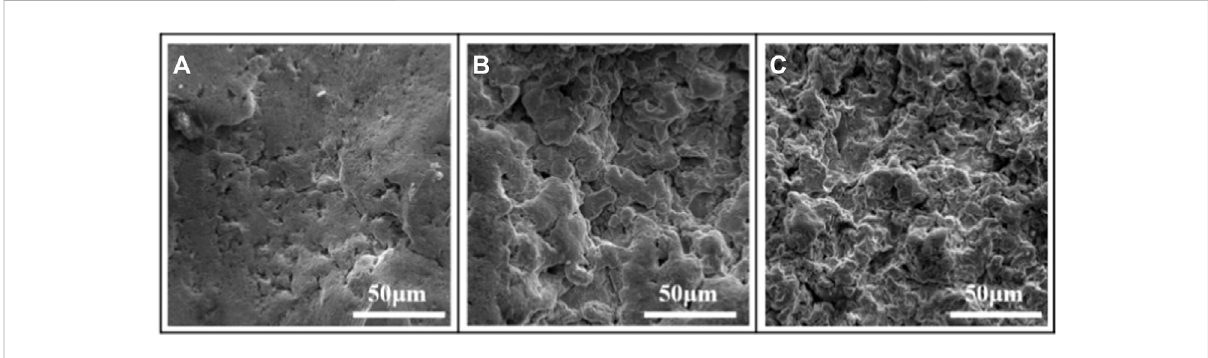
FIGURE 16 SEM photographs of specimen surfaces in distilled water (B) and mixtures with sediments at a concentration of 85 kg/m 3 and various sizes (26 μ m (A) , and 253 μ m (C) ) at 240 min (Lian et al., 2018).